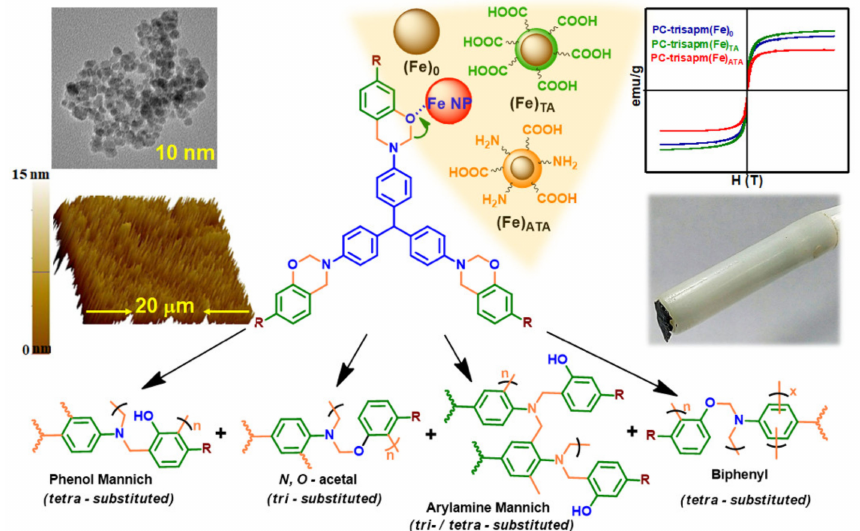
Figure 54. Probable linkages in the PBz network due to iron-oxide NPs mediated polymerization; AFM 3D images indicating surface topography of NPs in PBz; hysteresis curve and digital photos of composite showing magnetic property [90]. Copyright 2018. Reproduced with permission from WILEY-VCH Verlag GmbH & Co. KGaA, Weinheim, Germany.